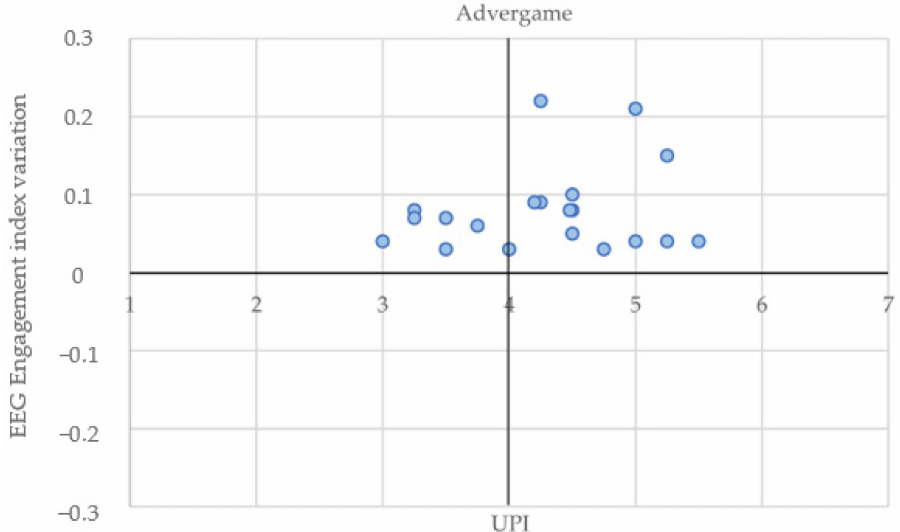
Figure 9. Advergame—Quadrant model of EEG engagement index variation vs.